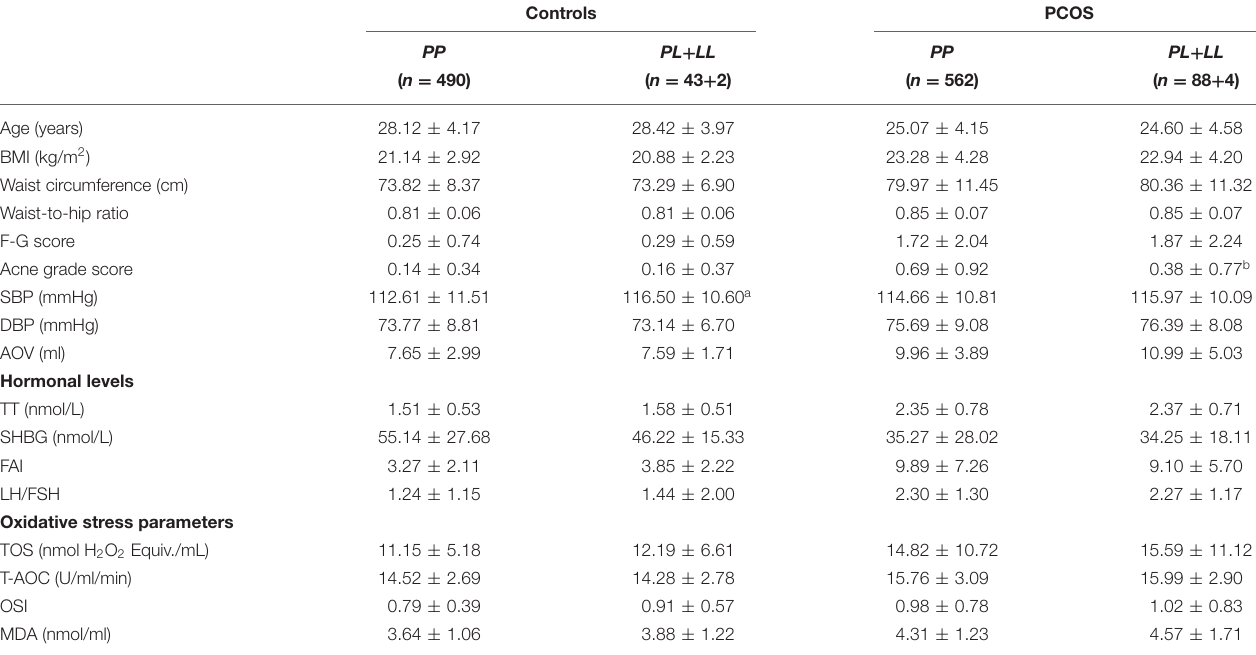
TABLE 4 | Clinical characteristics, hormonal levels, and oxidative stress parameters of the GPx P198L (Pro198Leu) genotypes in PCOS patients and controls.